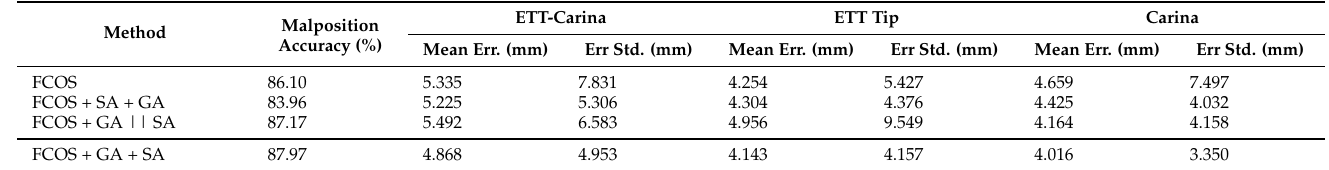
Table 19. The results of GA and SA fusion method.